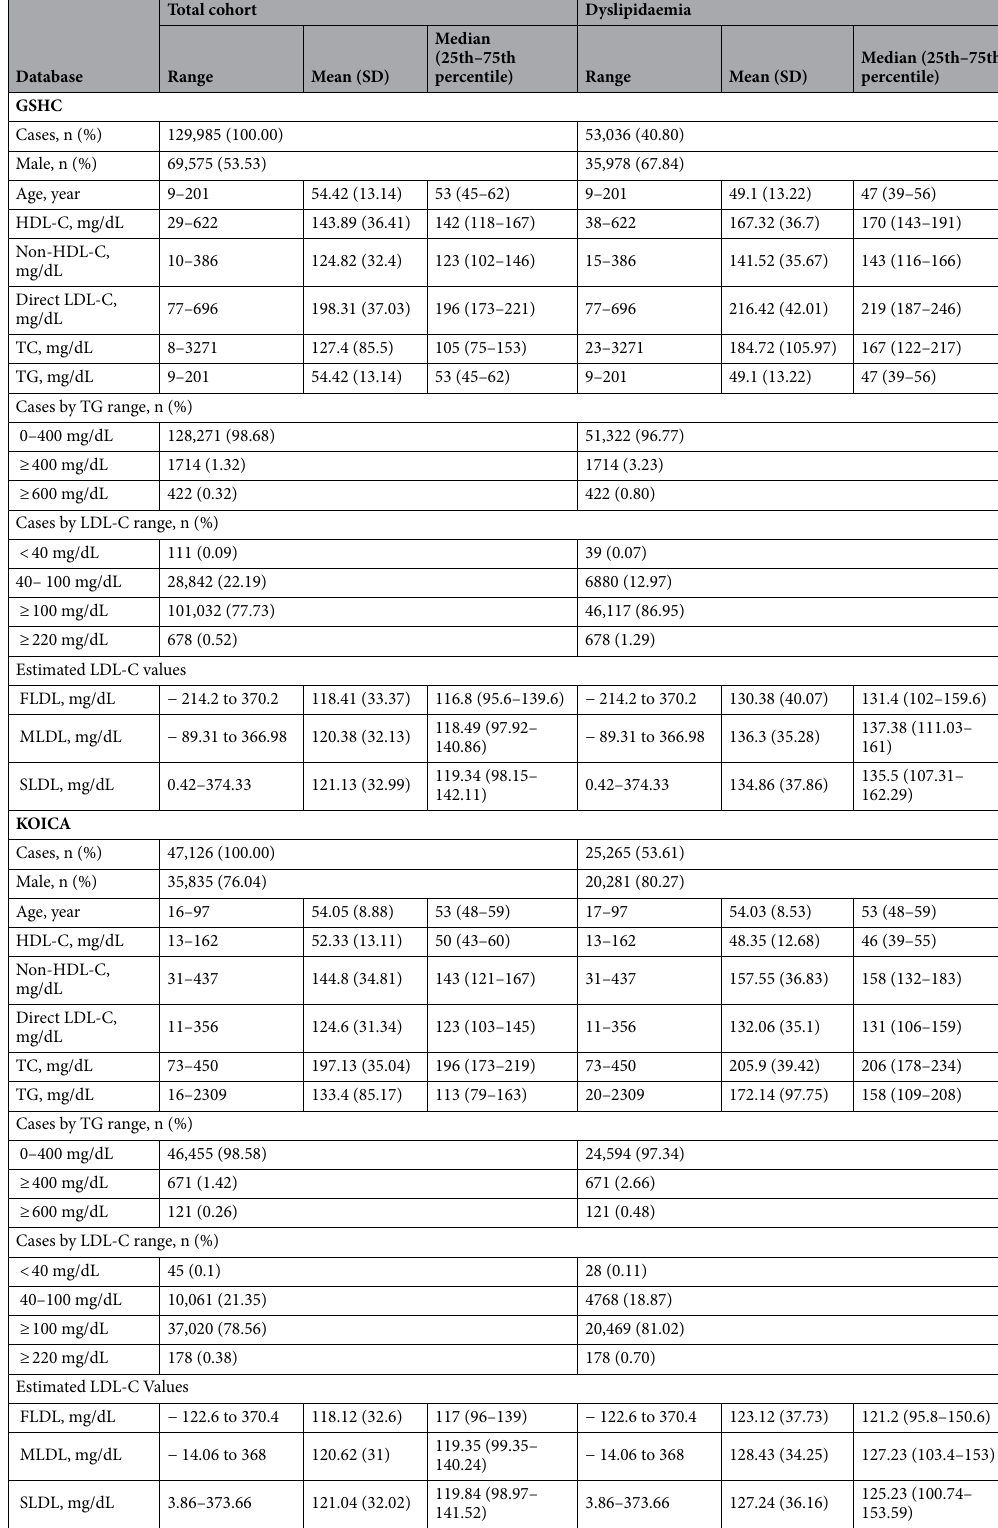
Table 1. Distribution of lipid parameters of the study populations. Values are presented as mean (standard deviation), median (interquartile range), or as number (%). SD standard deviation; n, number; HDL-C high- density lipoprotein cholesterol; Non-HDL-C non-high-density lipoprotein cholesterol; TC total cholesterol; LDL- C low-density lipoprotein cholesterol; dLDL direct LDL-C; TG triglyceride; GSHC Gangnam Severance Hospital Check-up; KOICA Korea Initiatives on Coronary Artery Calcification; FLDL LDL-C estimated by Friedewald’s equation; MLDL LDL-C estimated by Martin/Hopkins equation; SLDL LDL-C estimated by Sampson’s